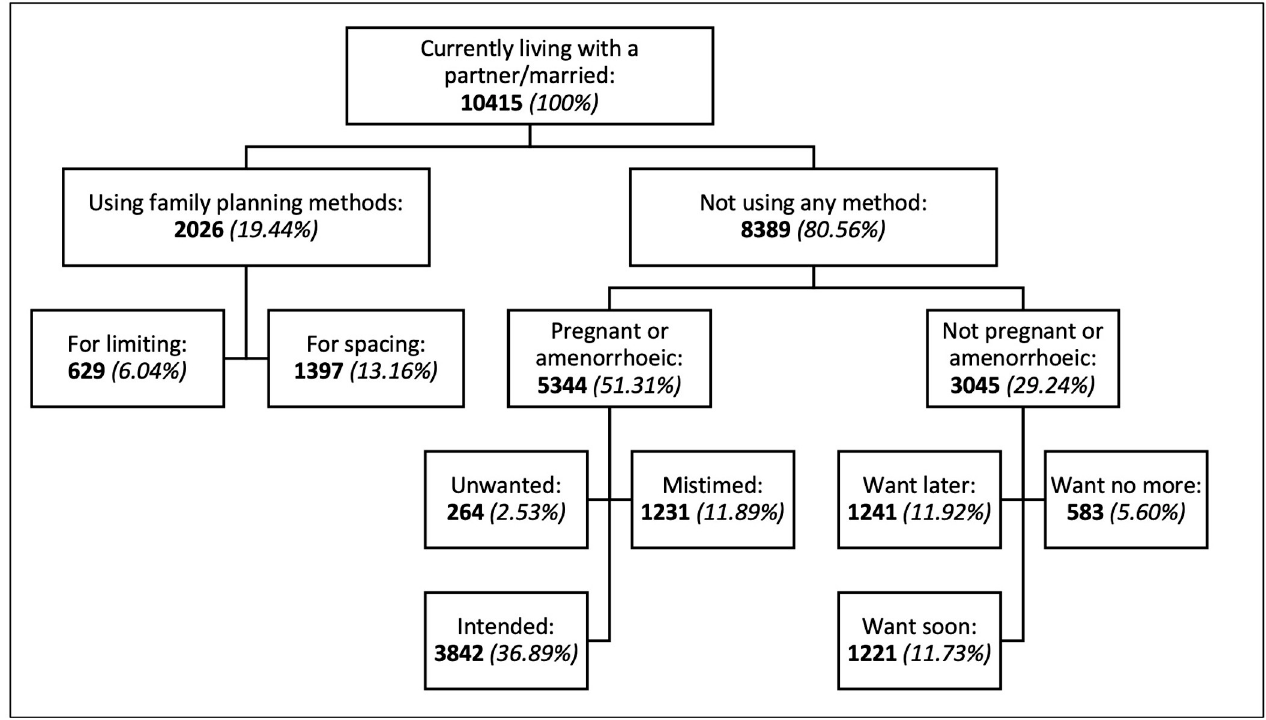
Fig 1. Unmet need among women of reproductive age who are married or living with a partner in DRC, 2014.